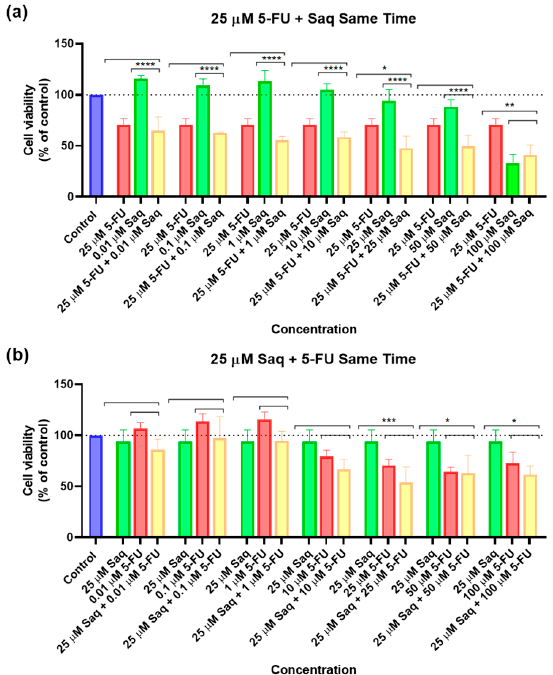
Figure 17. Cytotoxic results of A549 after exposure to drug combinations at the same time for 48 h. ( a ) Combination of 25 µ M of 5-FU with increasing concentrations of saquinavir (0.01–100 µ M); ( b ) combination of 25 µ M of saquinavir with increasing concentrations of 5-FU (0.01–100 µ M). Control cells were treated with 0.01% DMSO (vehicle). Cell viability was obtained using the MTT assay and the results are given as the mean ± SEM ( n = 3). * Statistically significant vs. drug alone at p < 0.05; ** statistically significant vs. drug alone at p < 0.01; *** statistically significant vs. drug alone at p < 0.001; **** statistically significant vs. drug alone at p < 0.0001.